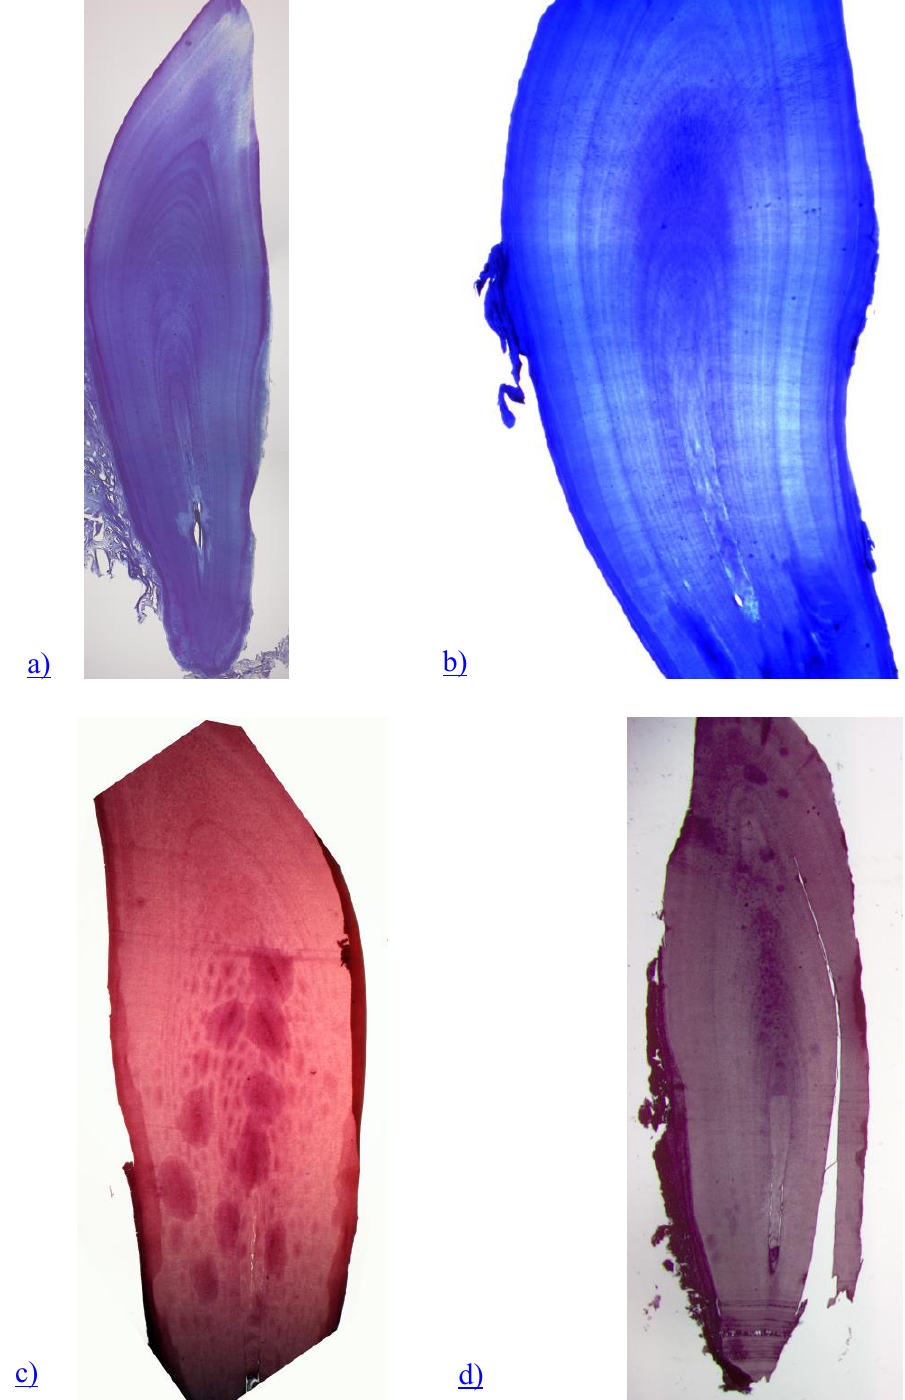
Fig.2 . Thin sections of teeth from Shona ; (a) decalcified using 10% Formic Acid, sectioned at 25 µ using a cryostat and stained using toluidine blue (x40 magnification); (b) decalcified using 10% EDTA, sectioned at 25 µ using a cryostat and stained with toluidine blue (x40 magnification); (c) decalcified using RDO, wax embedded and sectioned using a microtome at 5µ and stained using haematoxylin (x25 magnification) ; and (d) decalcified using Formical-4, wax embedded and sectioned using a microtome at 5µ and stained using haematoxylin (x12.5